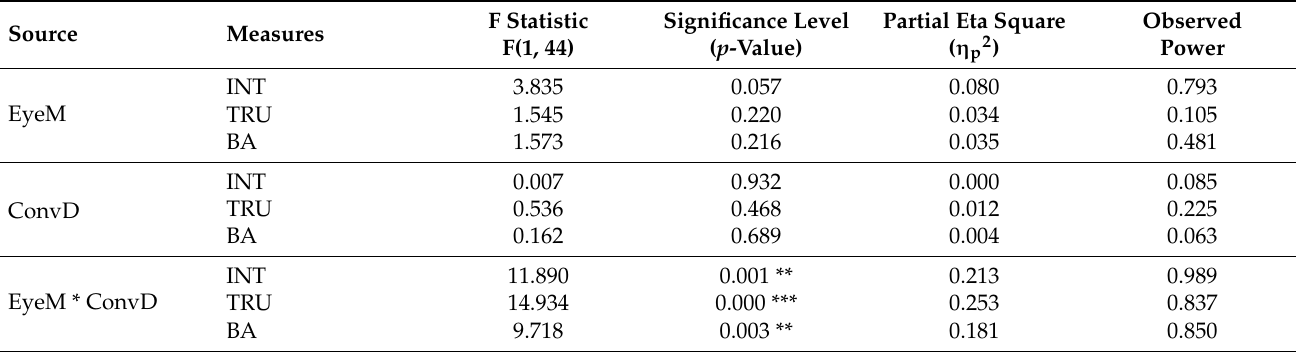
Table A11. Tests of Within-Subjects Effects for Pick-up service Scenario (N = 45).